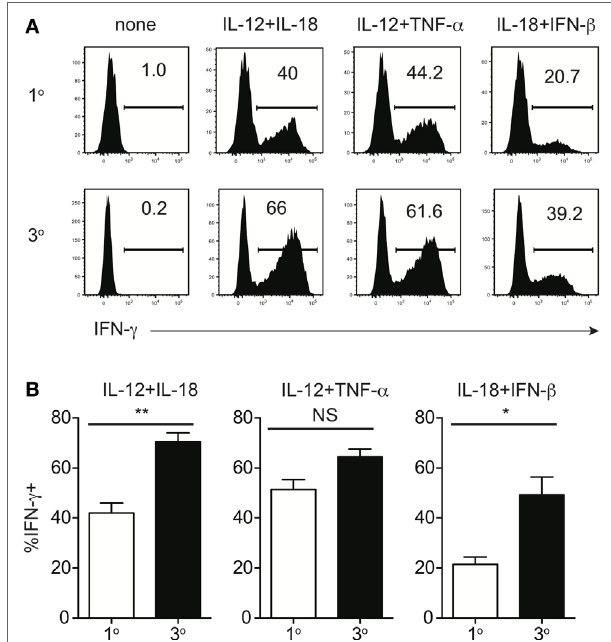
FigUre 5 | Memory CD8 T cell IFN- γ production in response to inflammatory cytokines increases with additional antigen encounters. Mice received adoptive transfer of naïve or 2° memory P14 cells and were infected with LCMV-Armstrong. 30 days after LCMV infection, splenocytes were harvested; mixed together; and incubated for 4 h with 10 ng/mL each of rIL-12 and IL-18, IL-12 and TNF- α , or IL-18 and IFN- β in the absence of Brefeldin A and for 1 additional hour in the presence of Brefeldin A. (a) Representative histograms of IFN- γ production by 1° (top) or 3° (bottom) memory P14 cells incubated with the indicated combinations of inflammatory cytokines. (B) Summary bar graphs of the percentage of 1° or 3° memory P14 cells producing IFN- γ following incubation with the indicated combinations of inflammatory cytokines. n = 3 mice/group. Representative data from 1 of > 3 independent experiments. Error bars represent mean ± SEM. Unpaired t -test; NS, not significant, * p < 0.05, ** p <